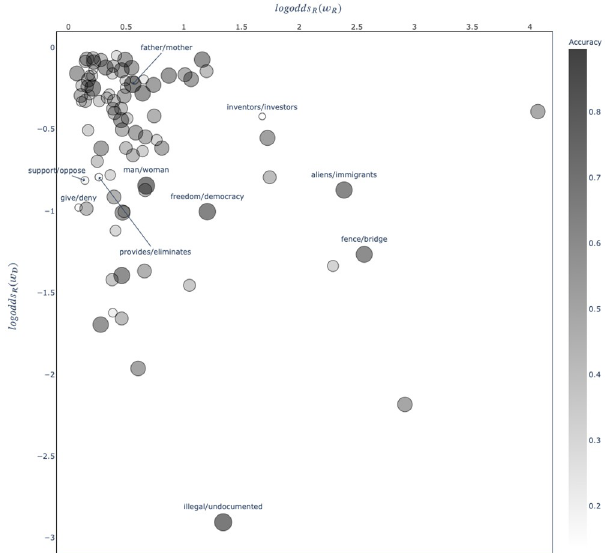
Fig 3. Results of Study 2. The logodds of the Republican word against the logodds of the Democratic word R R comprising each item. Markers are colored and sized by the mean participant accuracy. Large black dots indicate that when presented with this word pair, participants were usually able to identify which word was Republican and which word was Democratic. Small white dots indicate that when presented with this word pair, participants were systematically wrong about which word was Republican and which word was Democratic. The five pairs on which participants attained the highest average accuracy and the lowest average accuracy are labeled using the format Republican word/Democratic word . Highest accuracy: illegal/undocumented , man/woman , father/mother , freedom/ democracy and aliens/immigrants . Lowest accuracy: inventors/investors , give/deny , provides/eliminates , support/oppose and include/require